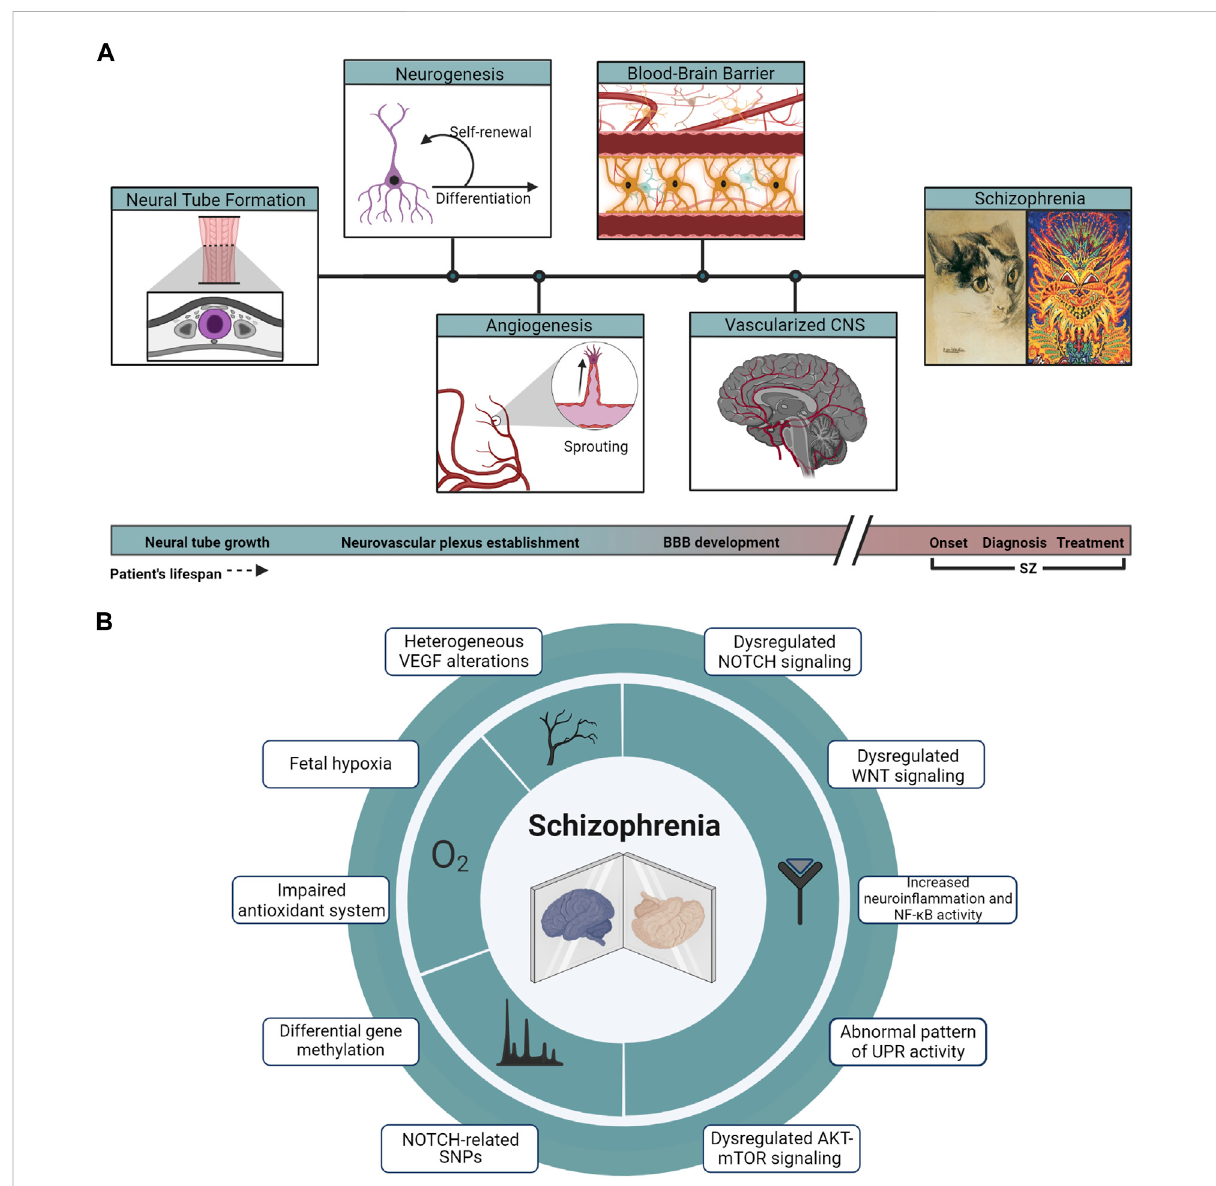
FIGURE 2 Developmentalandmolecularhallmarks inSZ. (A) Fromtheclosure and growth oftheneuraltube (highlighted inpurple fromacoronal section across the embryo ’ s axis) to a vascularized and developed brain, events of neurogenesis and angiogenesis take place across the developing tissue, leading to the establishment of the BBB, a key component in the physiopathology of SZ. Cat illustrations correspond to public domain paintings by Louis Wain, whose changing art style interprets as a representation of the onset and progression of the artist ’ s SZ. (B) Array summarizing the main genomic, signaling, and physiological hallmarks described in the physiopathology of